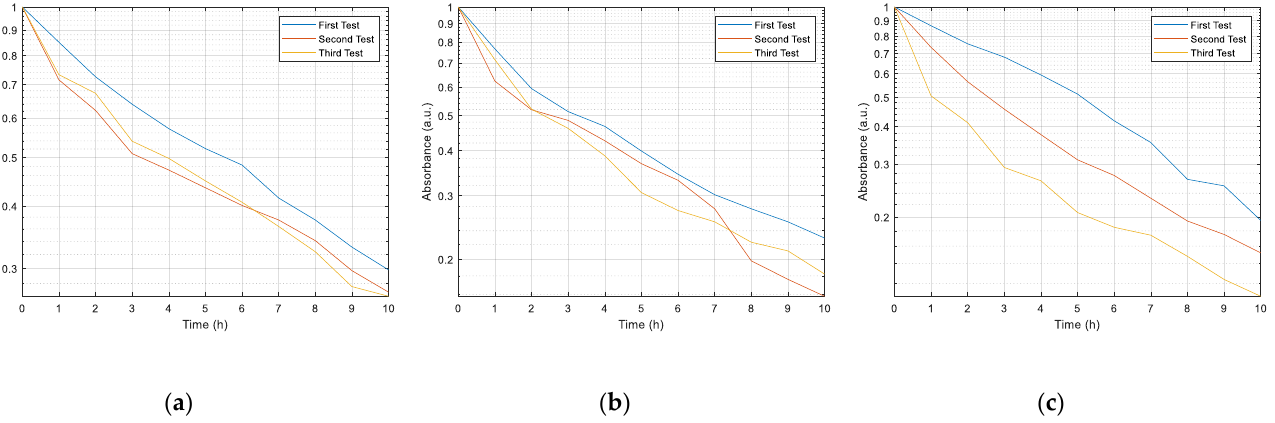
Figure 11. Photocatalytic reutilization of the different samples after three tests. ( a ) PAA + β - CD//TiO 2 /PAA; ( b ) PAA + β -CD//TiO 2 /PAA + WO 3 ; ( c ) PAA + β -CD//TiO 2 /PAA + Fe 2 O 3 .